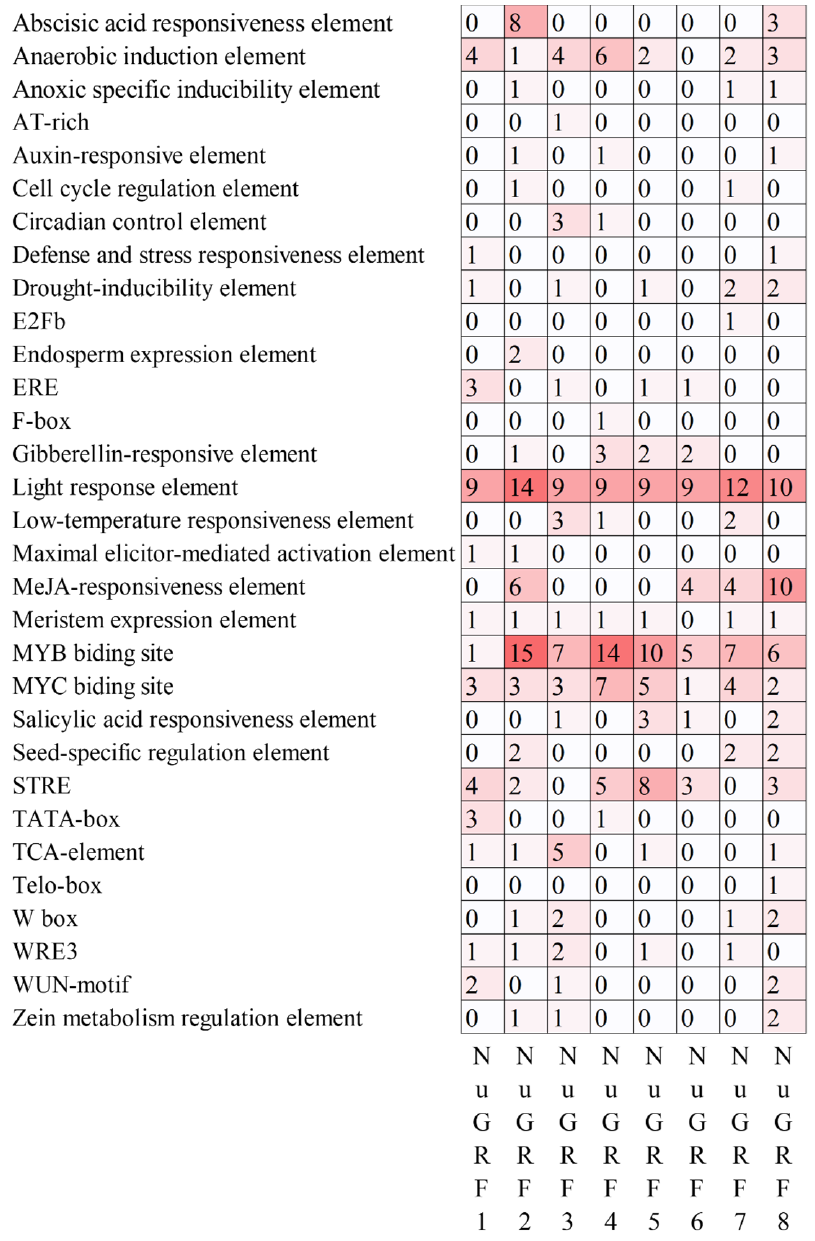
Figure 3. Analysis of cis-acting elements in the promoter regions of GRF genes. The degree of red color represents the number of cis-elements upstream of the NuGRFs; the numbers on the grid represent the number of cis-elements upstream of the NuGRFs.